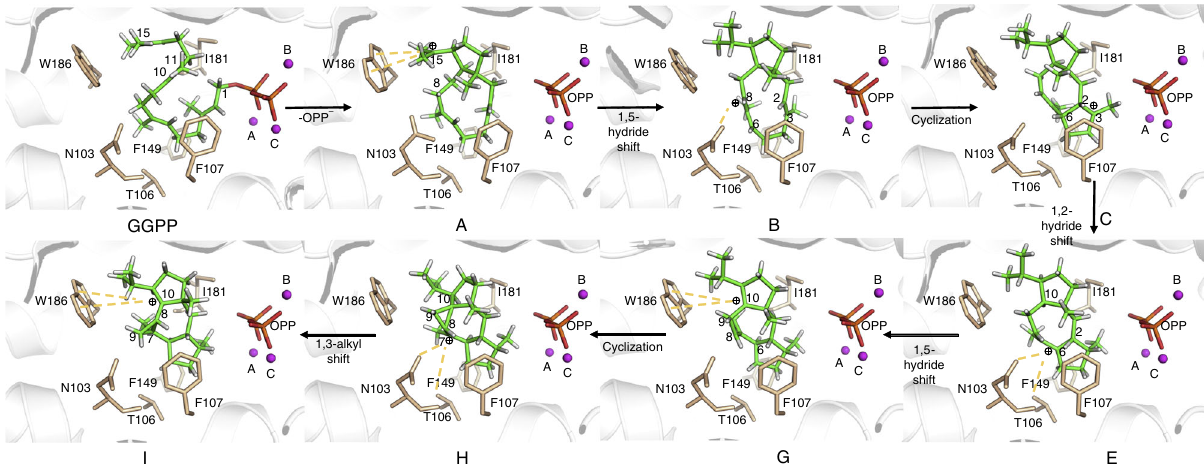
Fig. 4 Mechanistic model of initial and intermediate states of CotB2. The fi gure shows mechanistic steps corresponding to those in Fig. 3b. The models were obtained from QM/MM simulations. The dashed yellow lines indicate interactions between the intermediate cation and